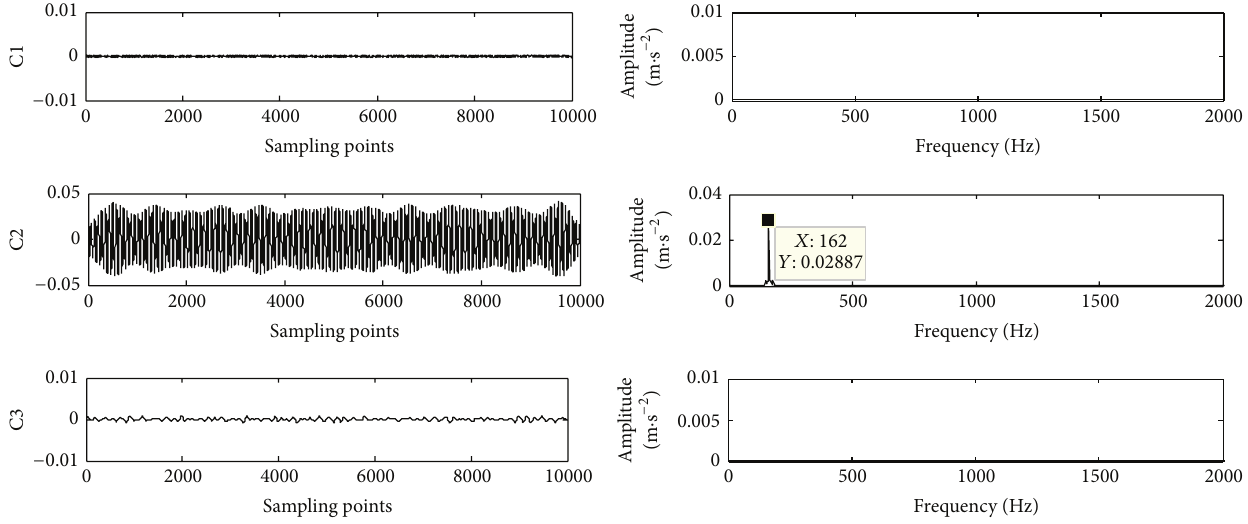
Figure 10: The AMD-EEMD components of stochastic resonance signal and its spectrum.